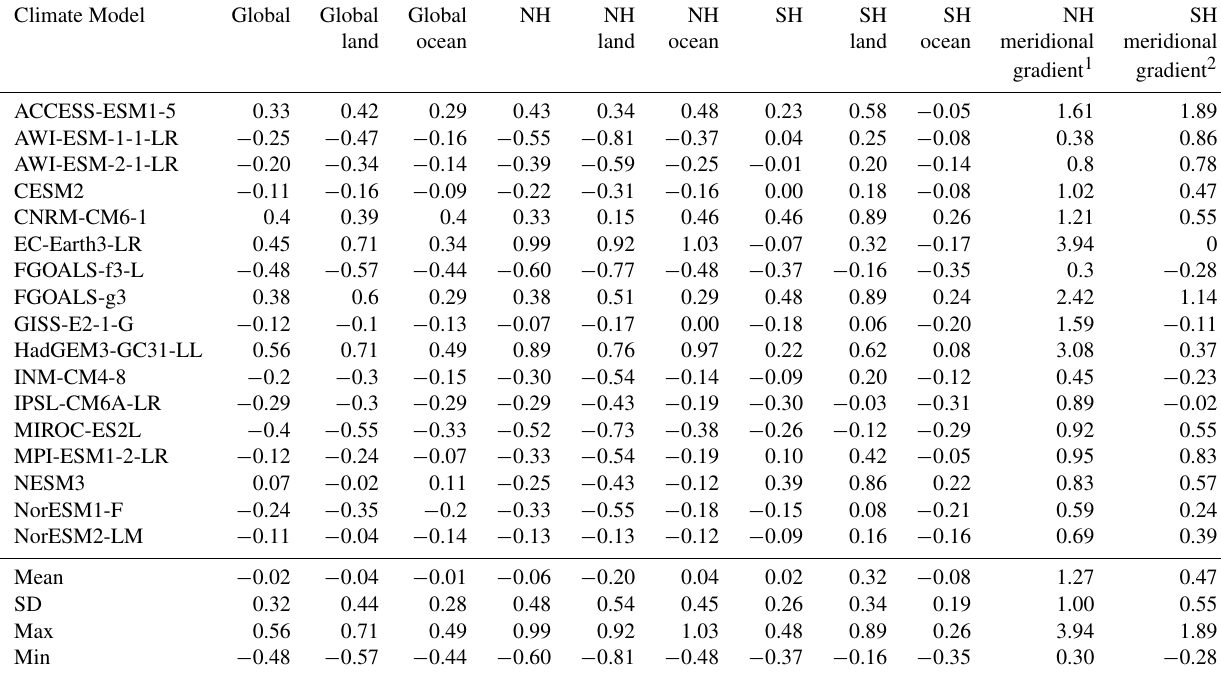
Table 3. Metrics for surface air temperature change ( ◦ C) for CMIP6–PMIP4 lig127k simulations. Climate Model Global